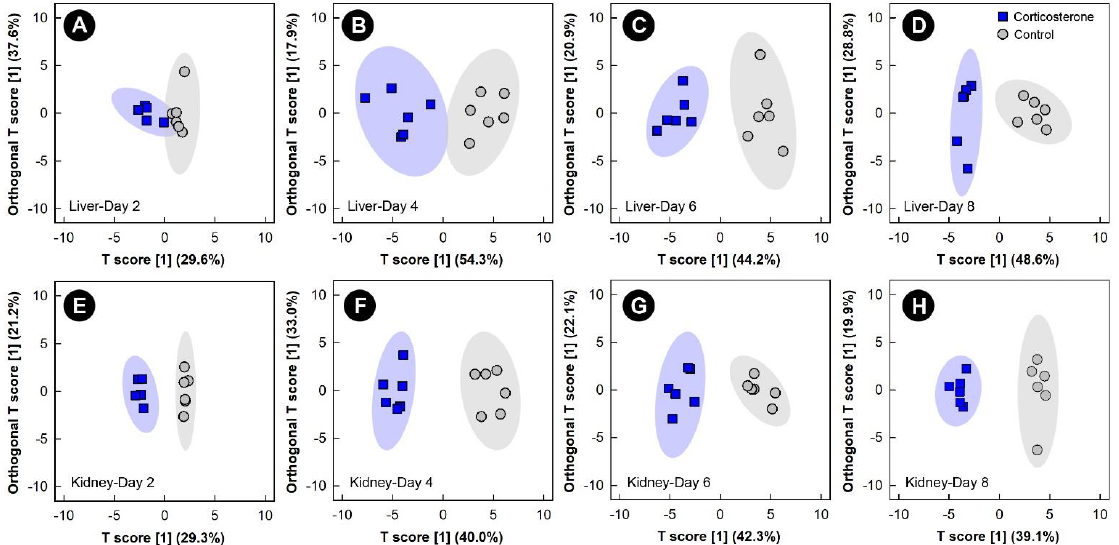
Figure 2. Orthogonal Partial Least Squares Discriminant Analysis (OPLS-DA) score plots of the liver and kidney metabolome of chicks administered corticosterone in their diet, or provided a diet free of glucocorticoid (control treatment), created using the spectral bins that were determined to be altered ( p ≤ 0.050) by Variable Importance Analysis , based on random Variable Combination (VIAVC) analysis, and/or the univariate Mann – Whitney U test. ( A ) Liver at day 2; ( B ) liver at day 4; ( C ) liver at day 6; ( D ) liver at day 8; ( E ) kidney at day 2; ( F ) kidney at day 4; ( G ) kidney at day 6; ( H ) kidney at day 8. The x - and y -axis in the OPLS-DA plots represent the predictive (between- group separation) and orthogonal (within-group variation) components of the data, respectively. Each marker represents one bird ( n = 6 per treatment), and shaded ellipsoids are the 95% confidence intervals for each treatment.